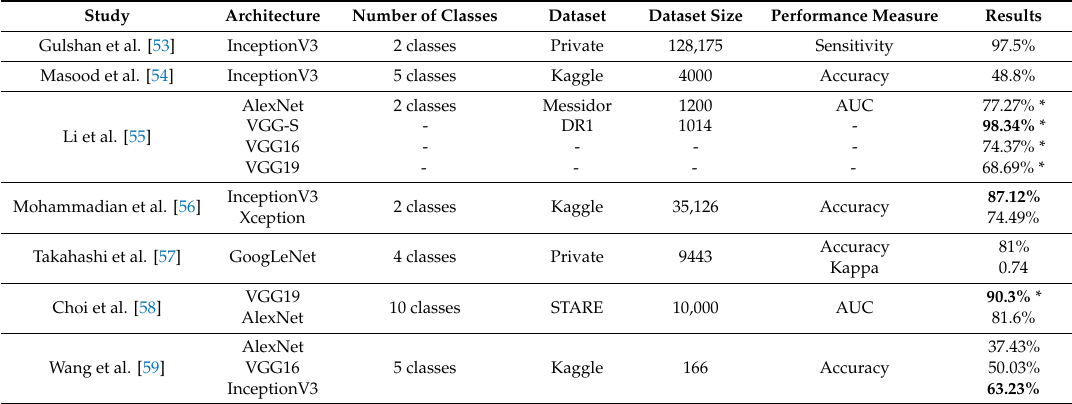
Table 3. Studies applying transfer